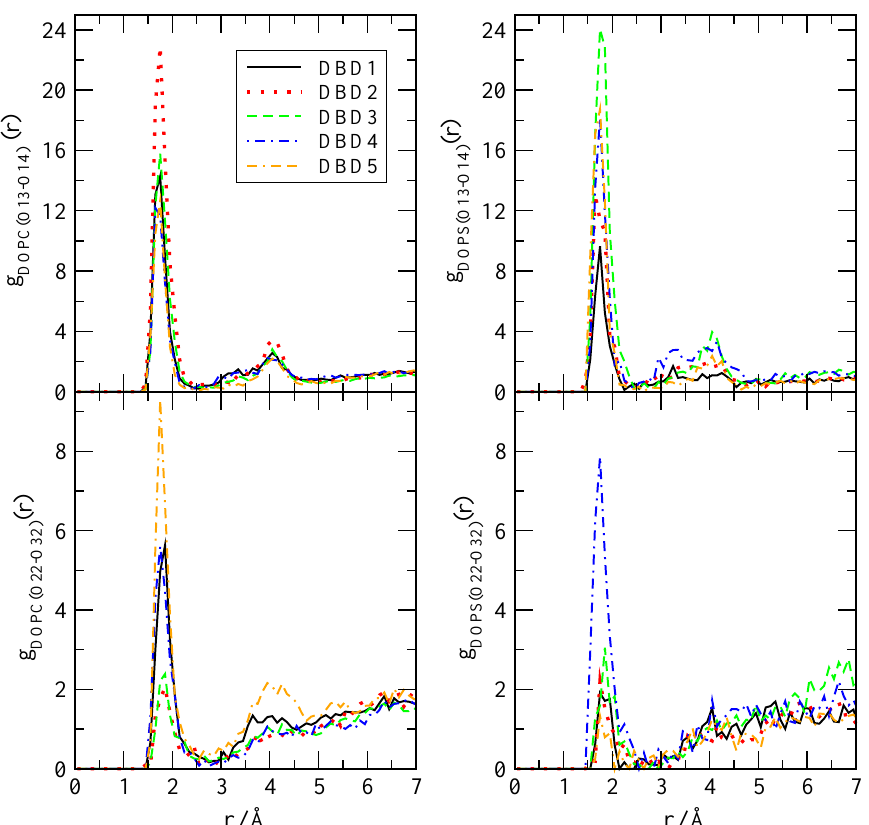
Figure 3. Radial distribution functions between site ‘H2’ of DBD derivatives and selected oxygen sites in DOPC and DOPS phospholipids. Sites ‘O13-14’ stand for head groups of the cell membrane phospholipids and sites ‘O22-32’ stand for tail groups located deeper in the membrane